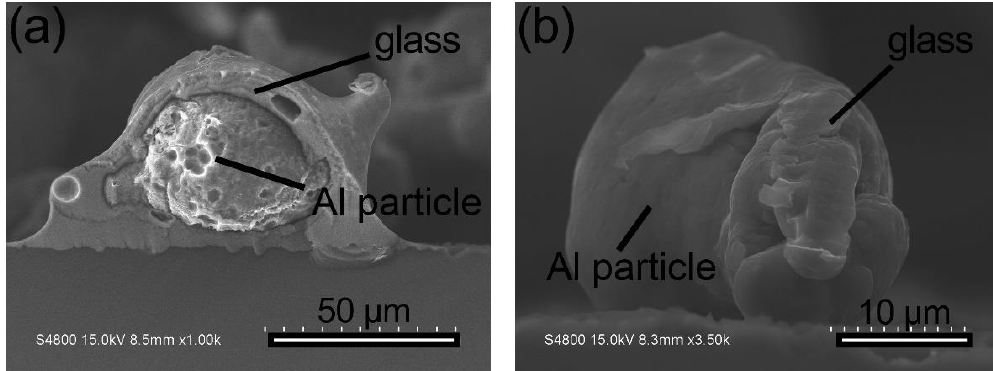
Figure 5. SEM images showing the interaction between glass and Al by heating the mixer of glass frit and Al powder at 700 °C for 1 min. (a) G-1 glass frit; (b) G-2 glass